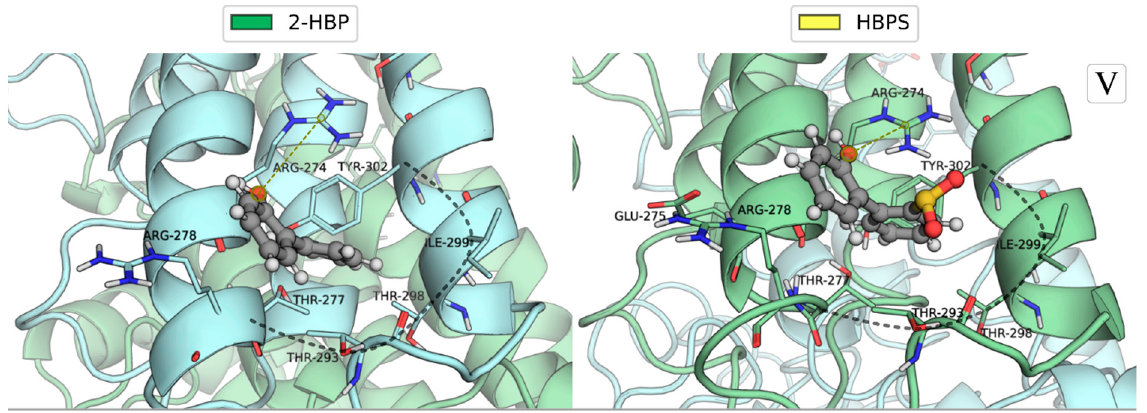
Figure 4. Representative pose of 2-HBP and HBPS at the binding site V. 2-HBP and HBPS are represented in ball-and-stick representation with carbons colored in gray. All residues composing the binding pocket and those within 4 Å of 2-HBP and HBPS are represented in stick representation. Residues within 4 Å of either 2-HBP and HBPS are labeled. Each monomer of DszC is represented in cartoon and colored green (chain A) or cyan (chain B). Hydrophobic patches are outlined with dashed gray lines, and hydrogen bonds are represented with dashed green lines.